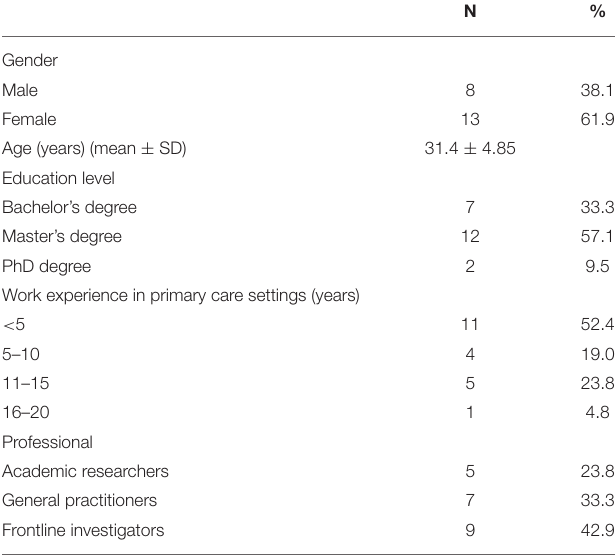
TABLE 2 | Characteristics of patients included in this study: N (%). Patient characteristics Random sample Random N